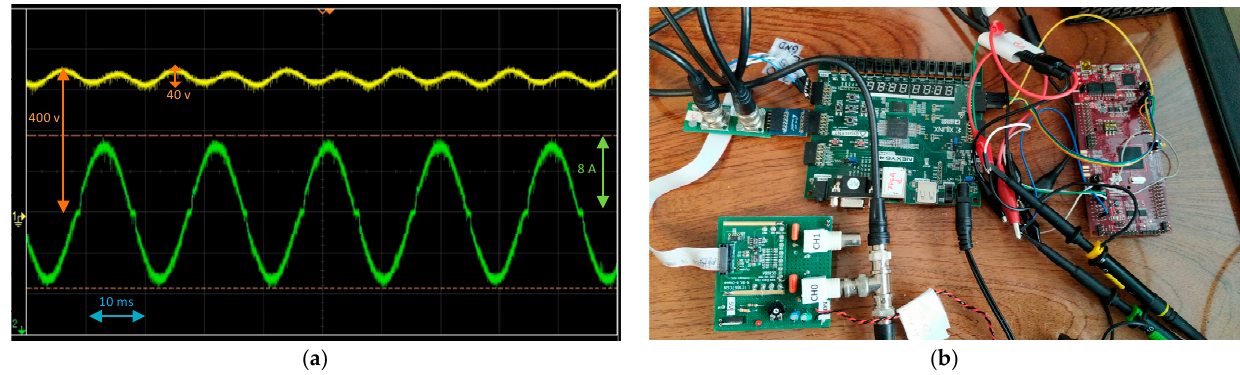
Figure 5. Control verification using HIL. ( a ) Waveforms of output voltage, v o , (yellow) and current trough the coil, i L , (green) and ( b ) laboratory setup.